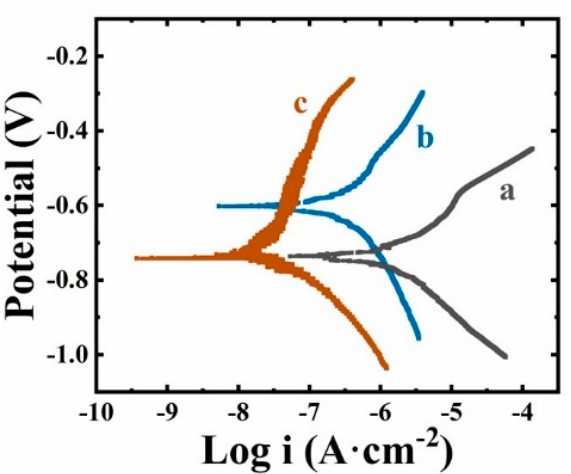
Figure 2. Tafel plots for ( a ) uncoated and coated substrates, ( b ) CAD sample, and ( c ) HiPIMS sample.